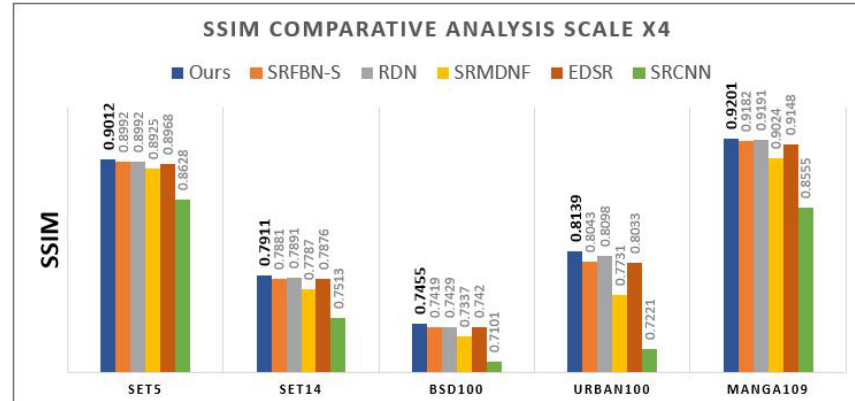
Figure 17. SSIM comparison at × 4 scale.